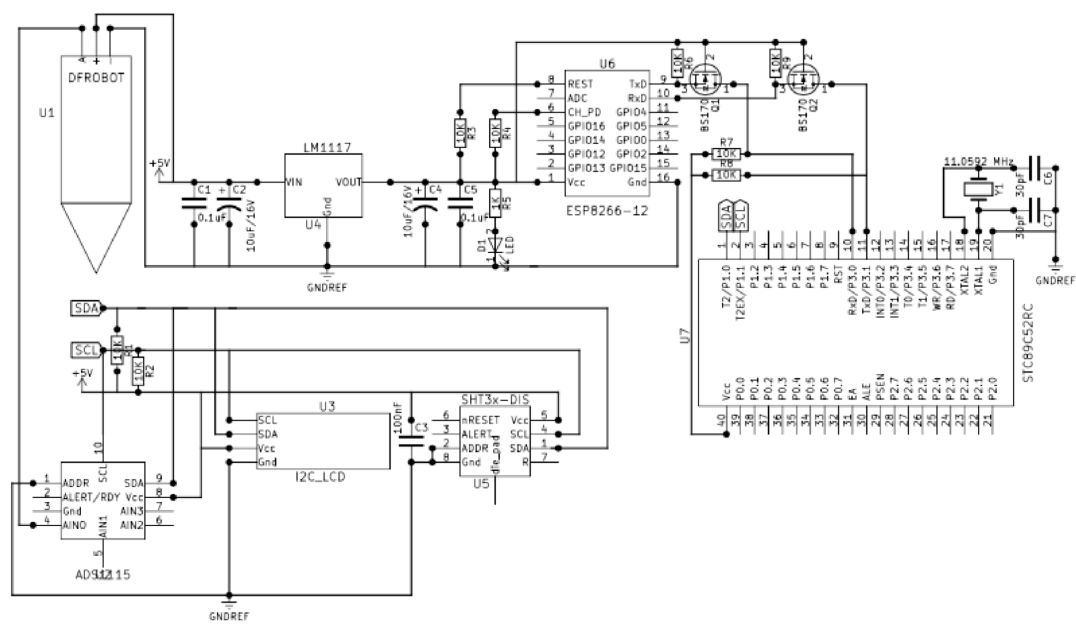
Figure 2. Circuit diagram of the data acquisition